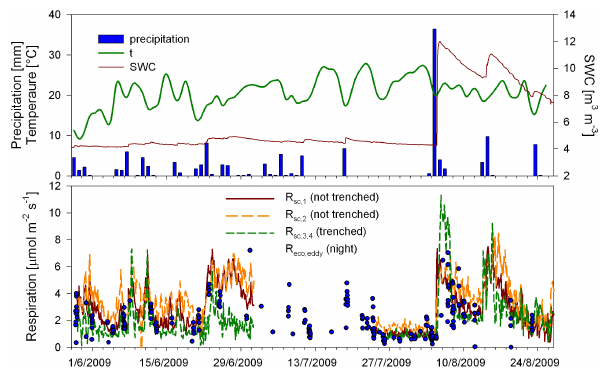
Fig. 2. Time courses of R eco (nighttime, storage corrected, u ∗ fil- tered (threshold: 0.1ms − 1 )) EC data, R sc from chambers placed in vegetation gaps (not trenched) and from the trenched plots (lower panel) and precipitation (upper panel left axis), daily average tem- perature (left axis) and volumetric soil water content (right axis) in the upper 30cm of the soil during summer, 2009 at Bugac site. Lack of R sc data (middle of the graph) was caused by disruptions in the electricity